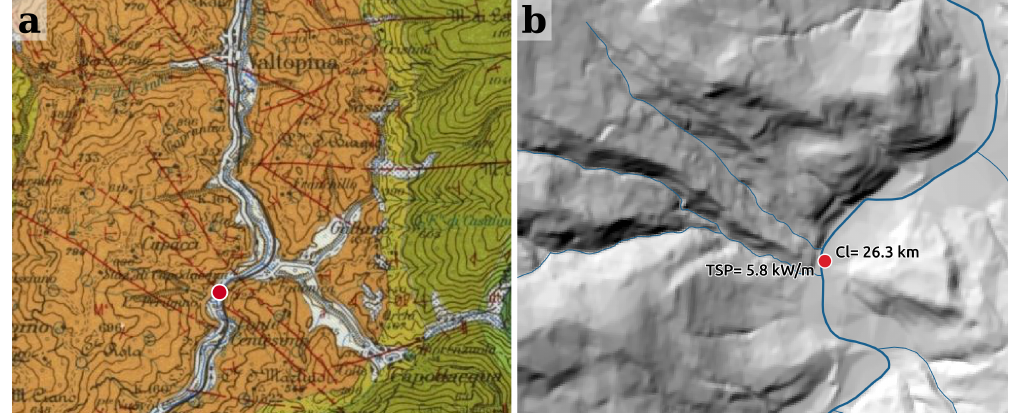
Figure 12. Peak #2 location. ( a ) shows an extract of the Geological Map of Italy at a scale of 1:100,000 (link: http://www.isprambiente.gov.it/en/cartography/geological-and-geothematic-maps/ geological-map-at-a-scale-1-to-100000, last access 04 April 2019) that displays a system of three faults; in ( b ), details of the DEM where the fault appears are clearly